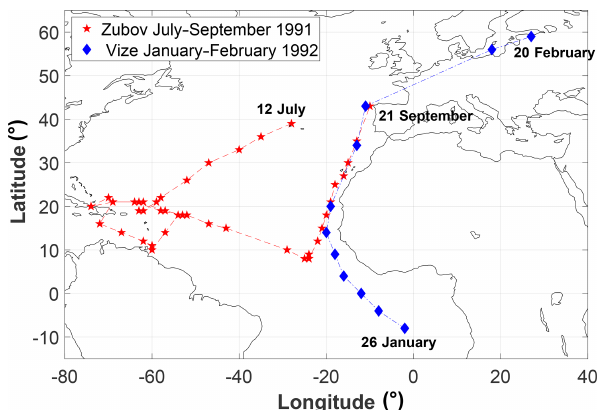
Figure 1. Trajectories of the Professor Zubov (red stars) between 12 July and 21 September 1991 and Professor Vize (blue diamonds) between 26 January and 20 February